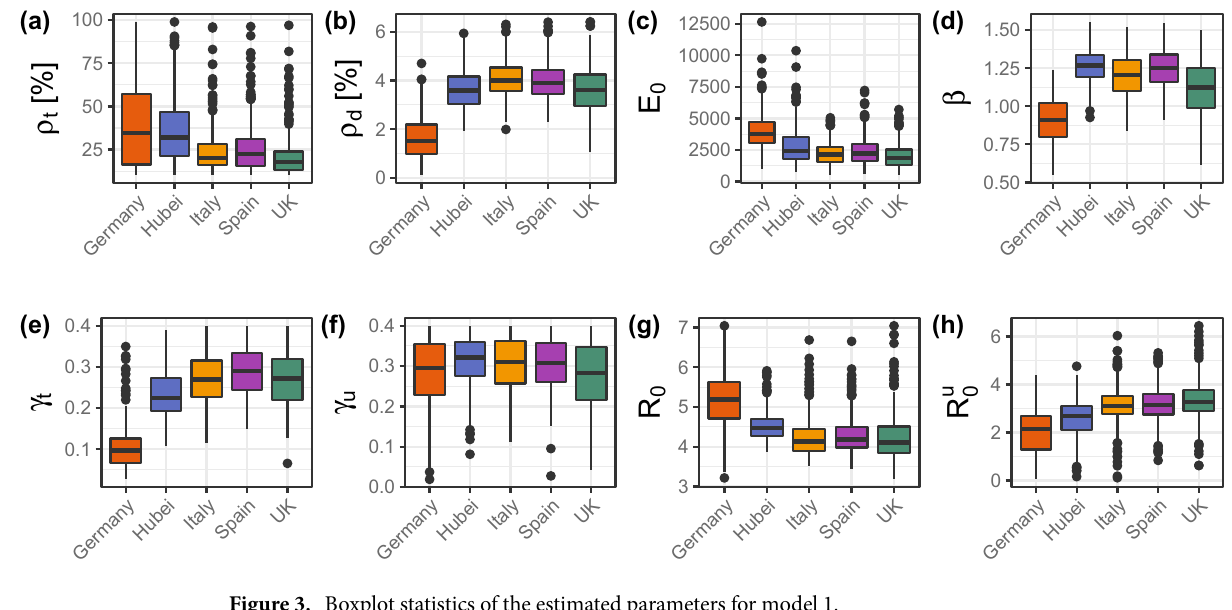
Figure 3. Boxplot statistics of the estimated parameters for model π( θ ) . In each realization, a simulation of Model 1 produces parameters sampled from a prior probability density deterministic evolution functions I t ( t ) and D ( t ) for the number of tested cases and cumulative deaths. The functions I t ( t ) and D ( t ) are used to build a random daily time series D sim ( θ ) = (cid:31)